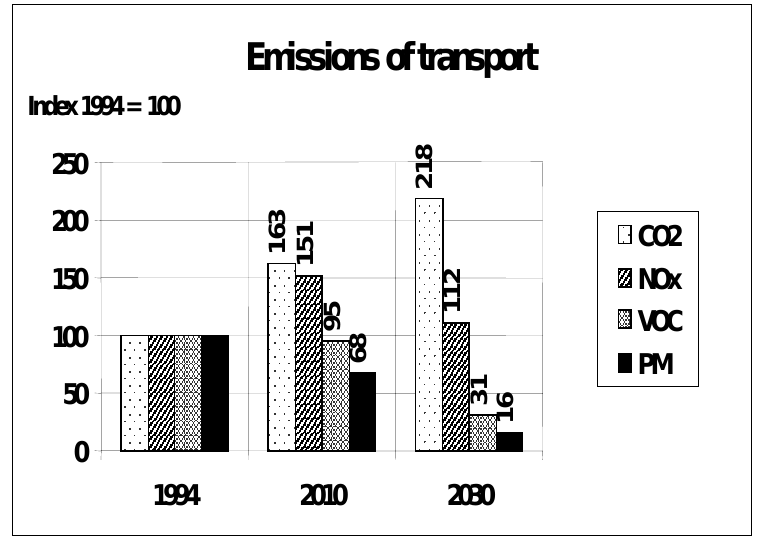
Figure 4: Current and projected emission trends in the CEI region 3. The need for Environmentally Sustainable Transport in the CEI: Selection and quantification of EST